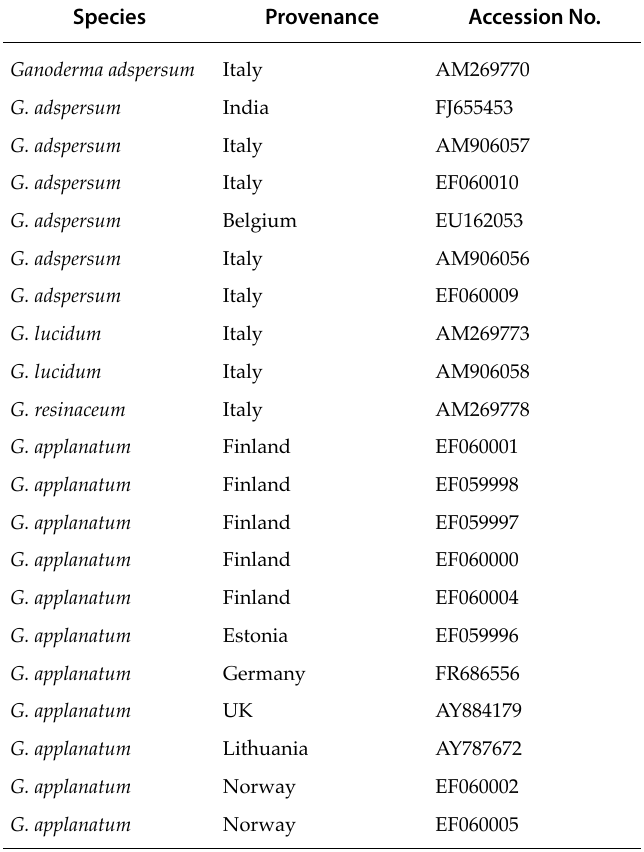
Table 2. Sequences of Ganoderma spp. from GenBank included in the analysis. Provenance and accession numbers are in- dicated. Species Provenance Accession